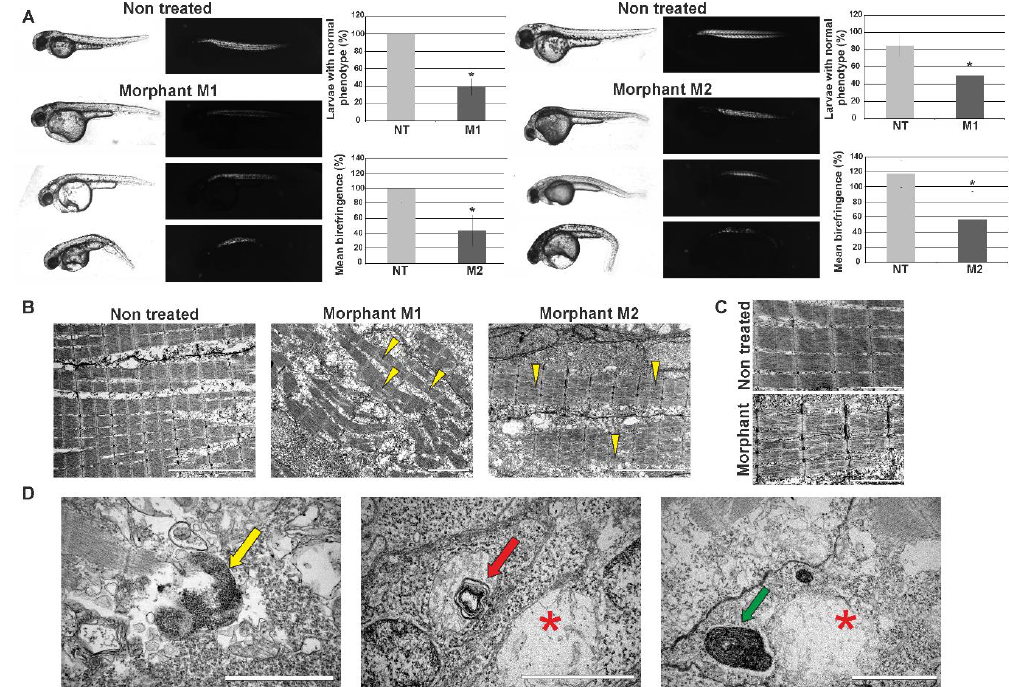
Figure 4. Effects of morpholino-mediated knockdown of zebrafish hspb8 on zebrafish embryo morphology and muscle structure. The effect of hspb8 knockdown was obtained through injections of morpholino oligonucleotides. 48 hpf zebrafish morphants (M1 and M2) were compared with control embryos (NT, non-treated). ( A ) The upper part of the panel shows representative images taken in normal light (the changes in morphology such as curved body, altered tail region, and pericardial edema are visible) and images presenting birefringence obtained in polarized light (Leica DM5000 light microscope, Leica, Munich Germany). The bottom part of the panel shows the phenotype quantification and its statistical evaluation. The phenotype quantification was conducted based on embryos morphology and their trunk muscle birefringence. The number of individuals in the control group (NT) with normal phenotype was taken as 100%. The analysis revealed that the differences between morphants (M1, M2) and control (NT) groups are statistically significant (indicated by an asterisk). The phenotype observed in over 50% of morphants was manifested in di ff erences in body size and shape, particularly in the tail part. Moreover, pericardial edema, which is a consequence of abnormal accumulation of fluid in the pericardial cavity, occurred. The quantification of trunk muscle birefringence of individuals in the control group (NT) was taken as 100%. Statistical analyses were performed using Student’s t -test, p < 0.05, n = 20–15 in each group; each experiment was repeated at least three times. Asterisks (*) indicate significantly di ff erent groups. Error bars show the standard deviation. ( B ) Ultrastructural analysis of morphants’ (M1, M2) and control embryos’ (NT) muscle. Note the disruption of sarcomere organization in morphants’ muscles. The disruption is manifested as the appearance of gaps between filaments within the sarcomere (yellow arrowheads). Scale bar: 5 µ m. ( C ) Magnified regions of sarcomeres in muscles of morphant and control individuals (non-treated). Note the disruption of sarcomere organization and accumulation of glycogen granules in morphants’ muscles. Scale bar: 2 µ m. ( D ) Ultrastructural analysis of structures present in morphants’ muscles. The membrane-bound autophagosomes containing glycogen (yellow arrow); mitochondrion with mitochondrial vacuolization (red arrow) in the vicinity of the swollen mitochondrion (red asterisk); structure built of a whorl-like inner membrane (green arrow) in the vicinity of a swollen mitochondrion (red asterisk). Scale bar: 0.5 µ